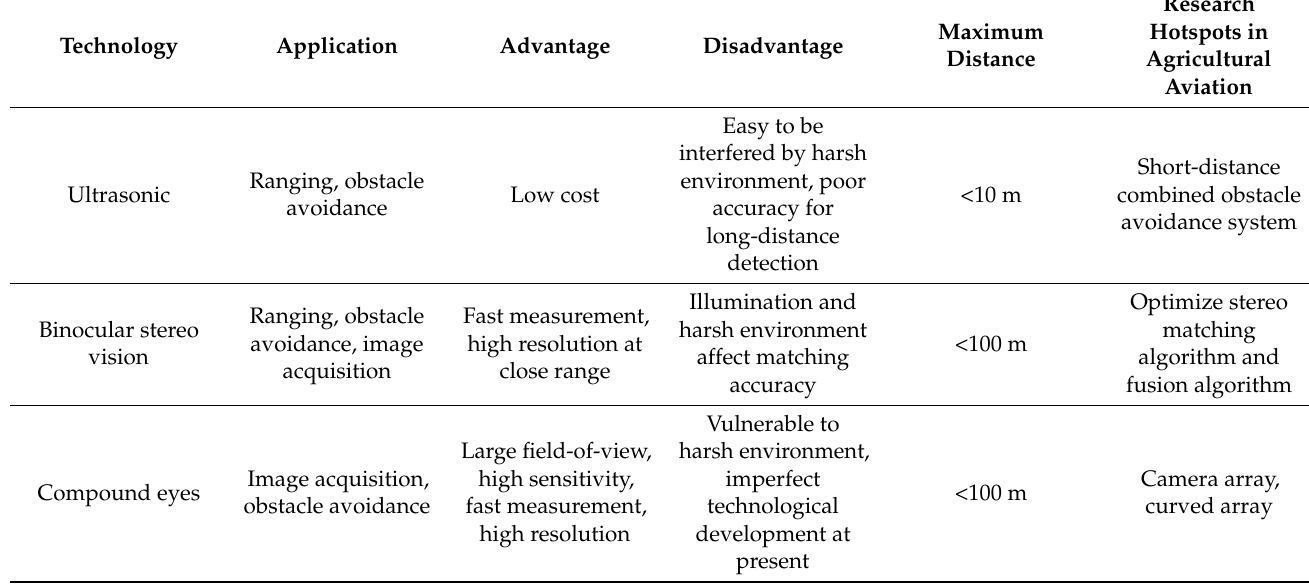
Table 1. Characteristics of bionic technologies and research hotspots in agricultural